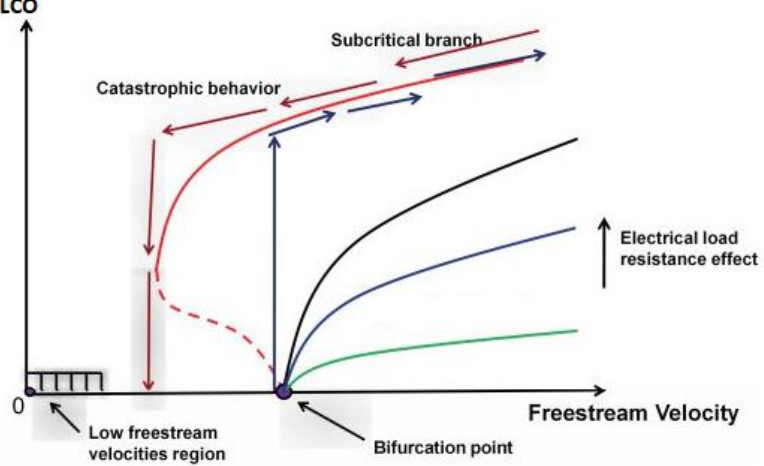
Figure 8. Bifurcation diagram [148]. In a dynamical system, this figure represents data points that have been approached or approximated by a system as a bifurcation parameter in a system revealing bifurcation theory. LCO: limit cycle oscillation.